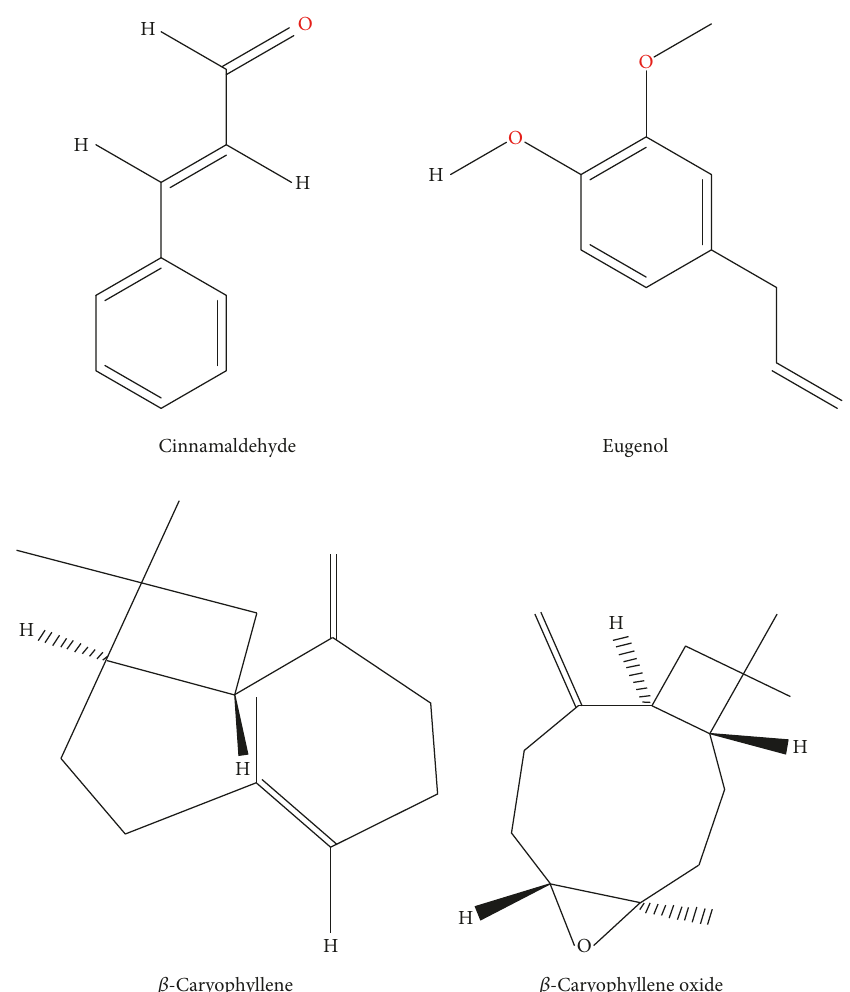
Figure 3: Chemical structures of different active compounds of cinnamon (adapted from PubChem Open Chemistry Database,